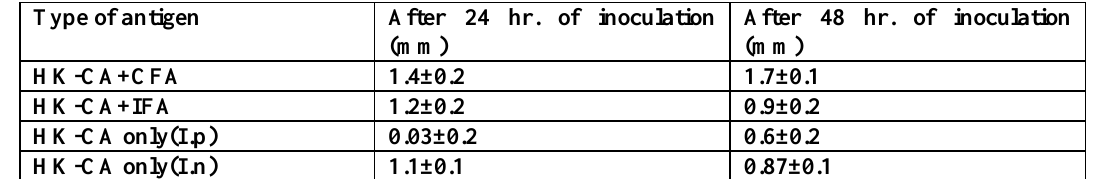
Table 1: DTH in mice immunized with HK-CA mixed with or without adjuvant after 2 weeks of last dose of